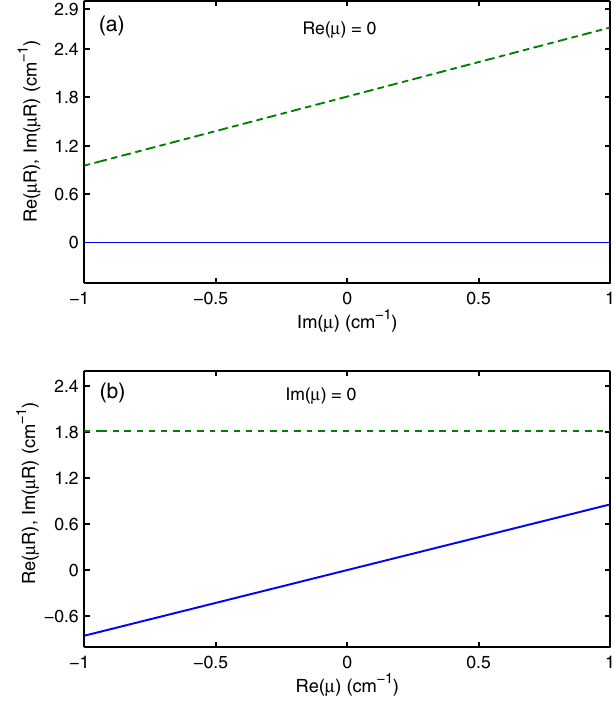
FIG. 4. Plots of imaginary (dashed) and real (solid) parts of μ R as a function of the imaginary (a) and real (b) parts of the growth rate parameter μ near the resonance frequency, i.e., 0.1 THz. By þ χ χ ¼ 1 . 81 per parametrizing R as i χ 1 in this graph, we obtain μ cm and χ 1 ¼ 0 . 86